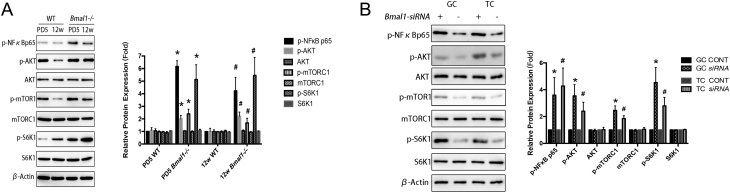
Bmal1 loss activated phosphorylation of NFκB/PI3K pathway. (A) Ovarian protein levels and quantitation assessment of Bmal1-knockout mice by Western blot. Left, a typical Western blot. Right, bands were densitometrically qualified and the intensities shown were normalized to β-Actin, relatively to WT control. PD 5, post-natal 5 days. Bmal1−/−, mice genotyped with whole bmal1 knockout. *P < 0.05 or less vs PD5 WT; #P < 0.05 or less vs 12 week WT. Data are presented mean ± s.d. of three independent experiments. (B) Protein levels and quantitation assessment of Bmal1-knockdown GCs and TCs with siRNA transfection. Left, a typical Western blot. Right, bands were densitometrically qualified and the intensities shown were normalized to β-actin, relatively to CONT of corresponding cell types. GC, granulosa cell. TC, theca cell. siRNA, group of cells transfected with siRNA knockdown Bmal1 transcriptions. CONT, cells transfected with siRNA with empty vector as controls. *P < 0.05 or less vs GC CONT. #P < 0.05 or less vs TC CONT. All data were the mean ± s.d. of three independent experiments where all the samples were repeated in thrice.